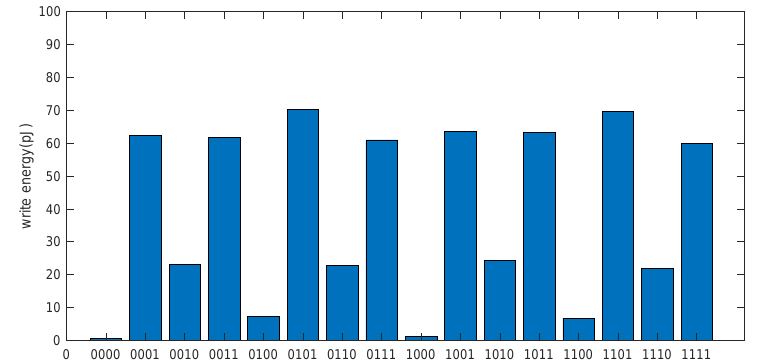
Figure 20. The energy consumption of 16 kinds of write